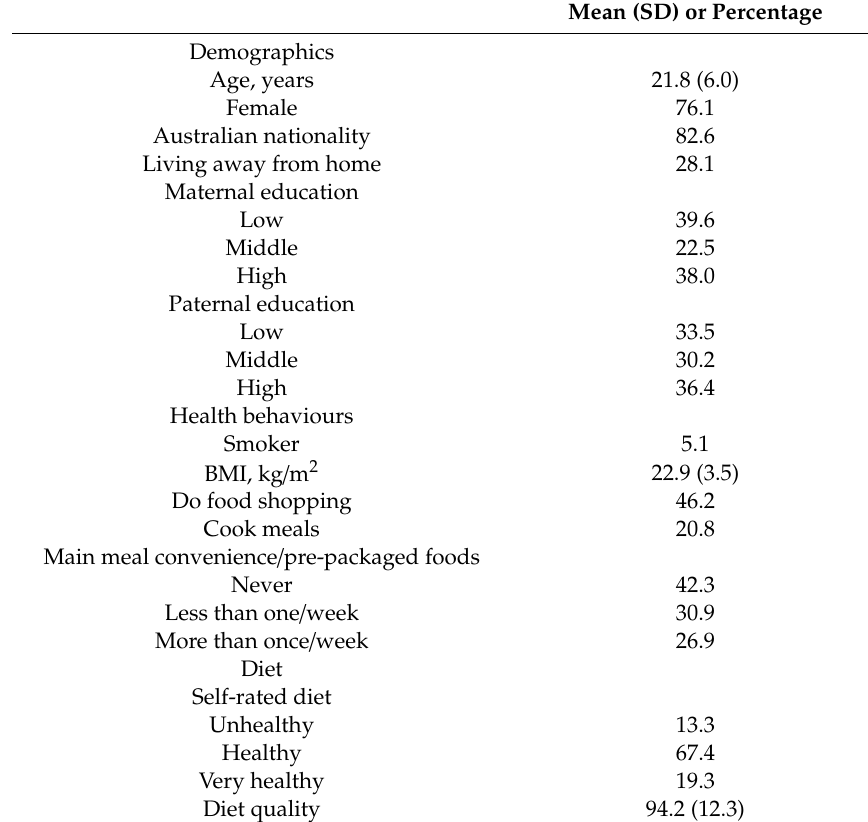
Table 1. Characteristics of young Australian adults ( n =